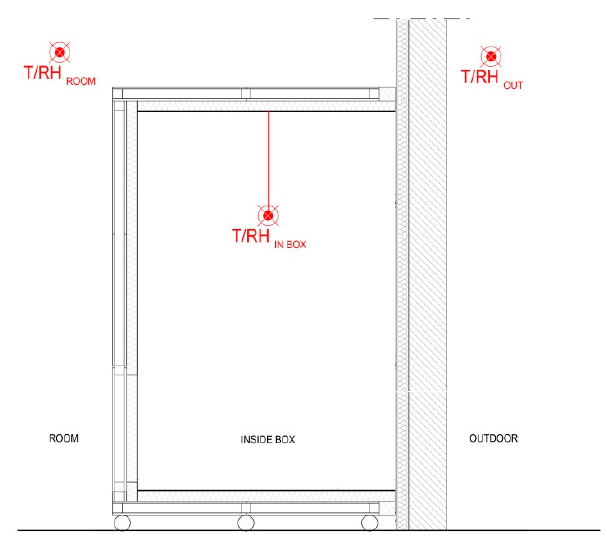
Figure 8. Vertical section of the metering box with the position of the T-RH combined sensors.